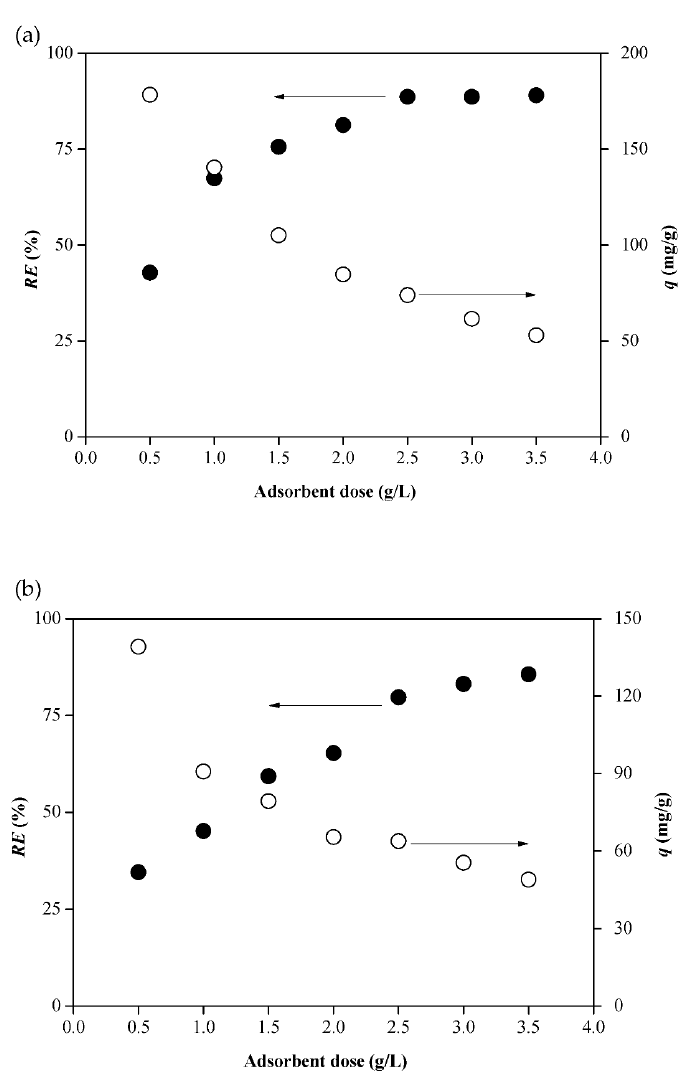
Figure 6. Effect of adsorbent dosage on the removal of ( a ) CV onto MHAF-SA and ( b ) RB4 onto MHAF-CS.